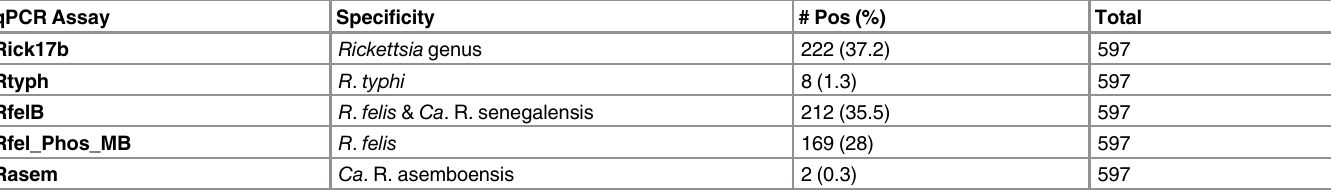
Table 1. A summary of qPCR assays